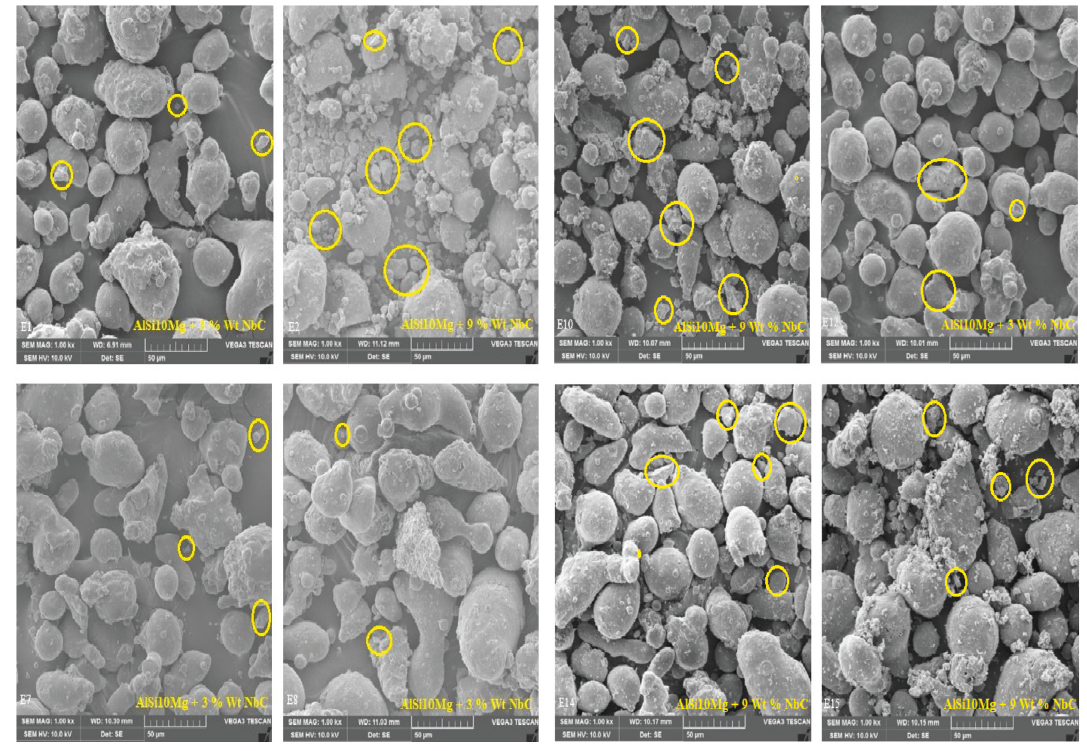
Figure 5: SEM images of factor-based experiments. Table 4: Analysis of variance and contribution of input